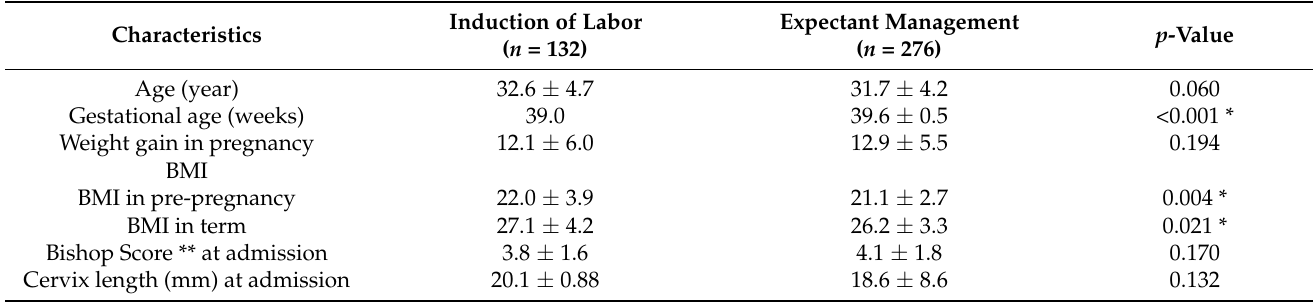
Table 1. Characteristics of women undergoing induced labor and expectant